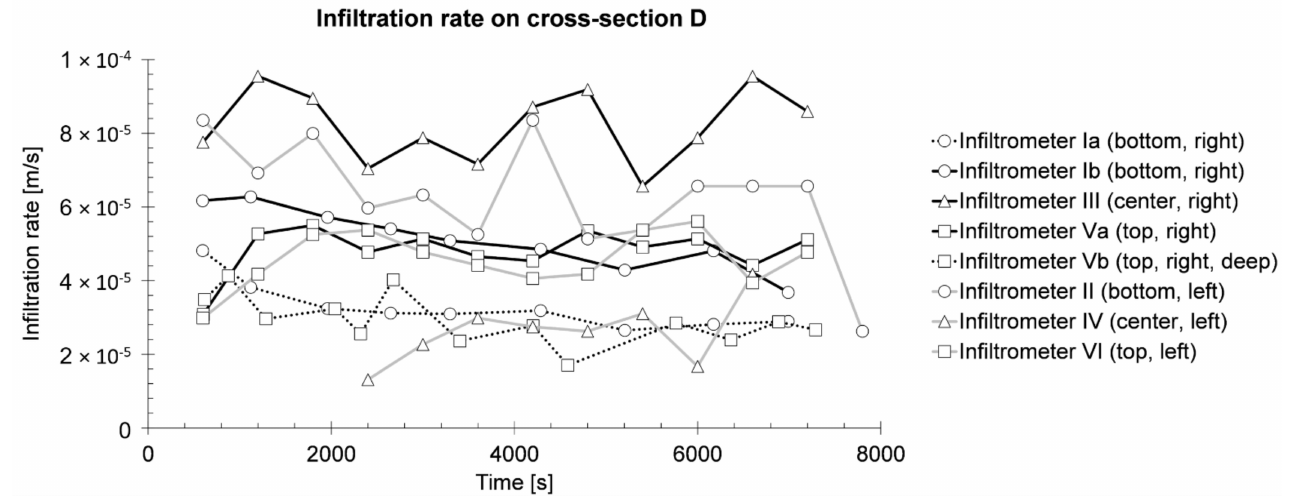
Figure 2. Results of double ring infiltration test on the eastern slope of cross-section D of Rostock research dike.